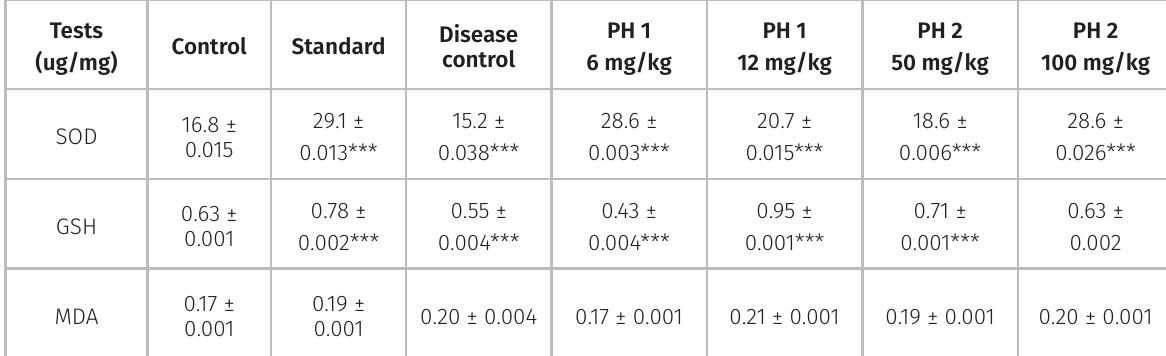
Table VI. Effect of polyherbal products on oxidative stress parameters in the lungs of asthmatic rats.